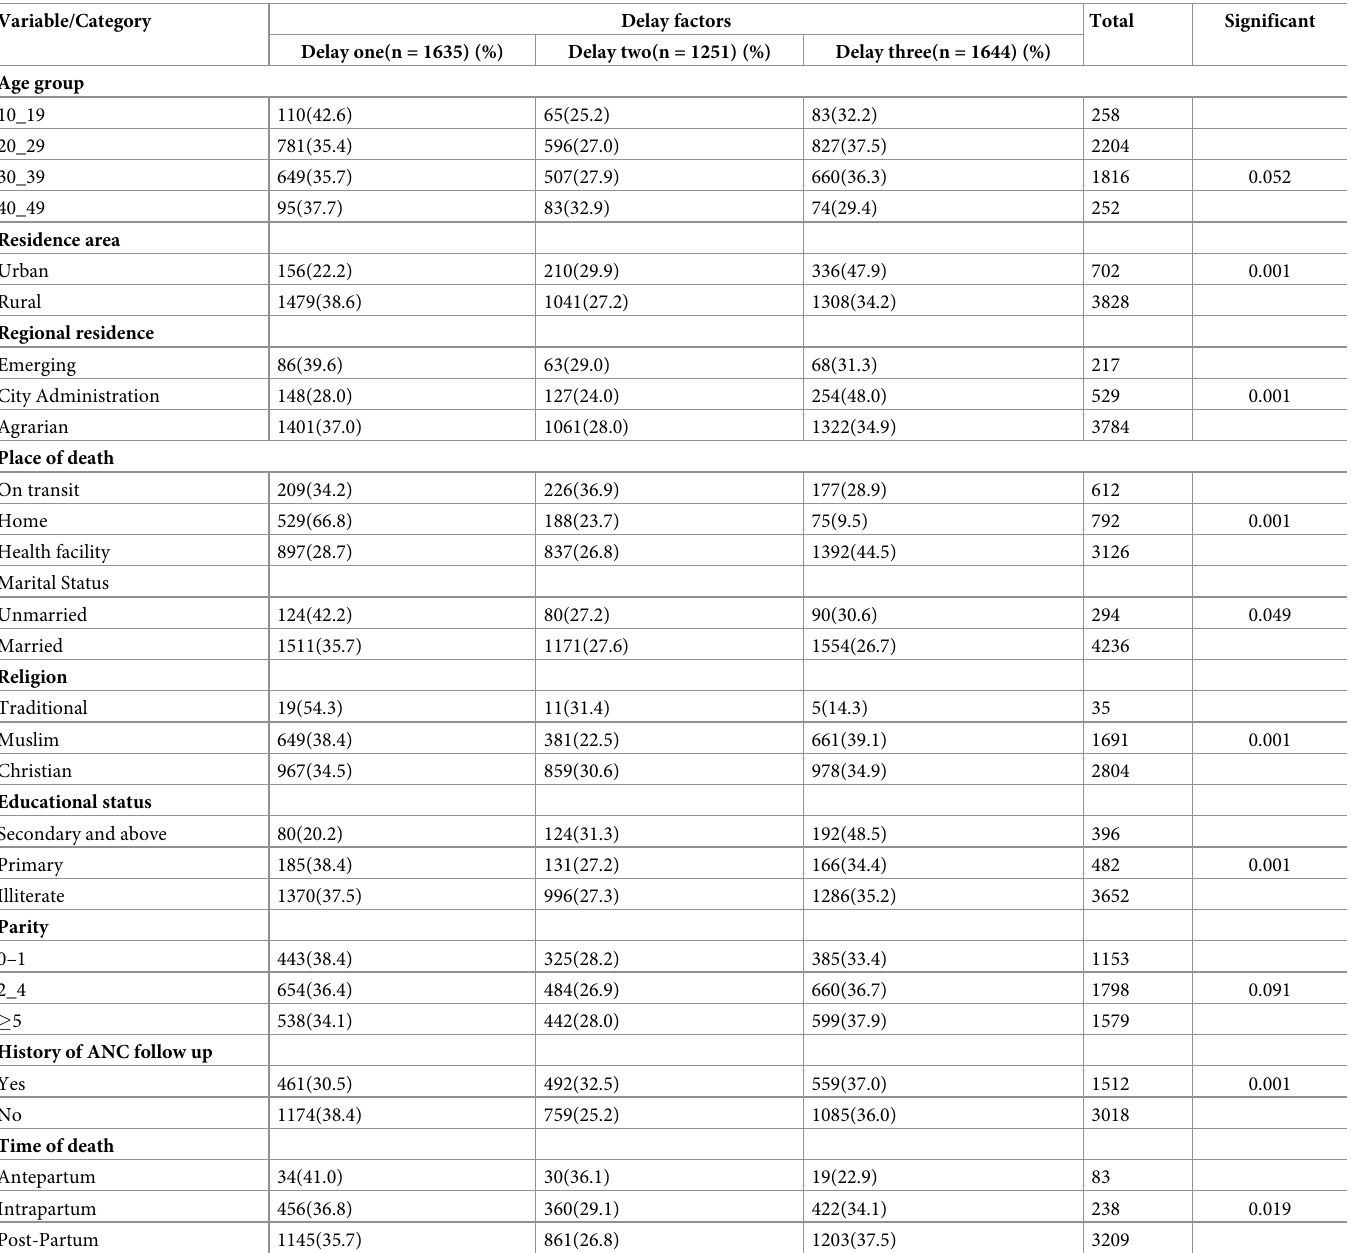
Table 2. Distribution of personal characteristics of the deceased women by delay factor in Ethiopia, 2021.